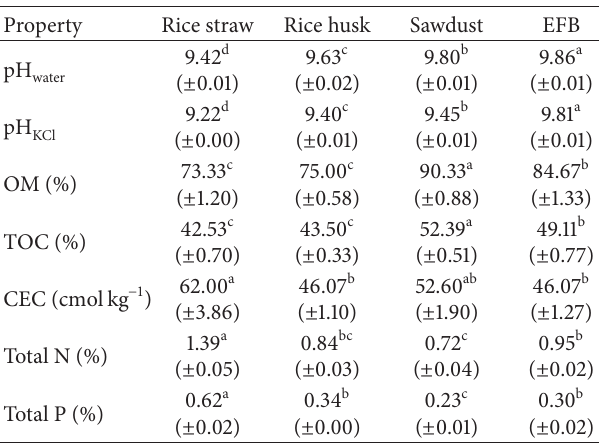
Table 8: Total and exchangeable cations (mgkg − 1 ) in crude humins from different composts.